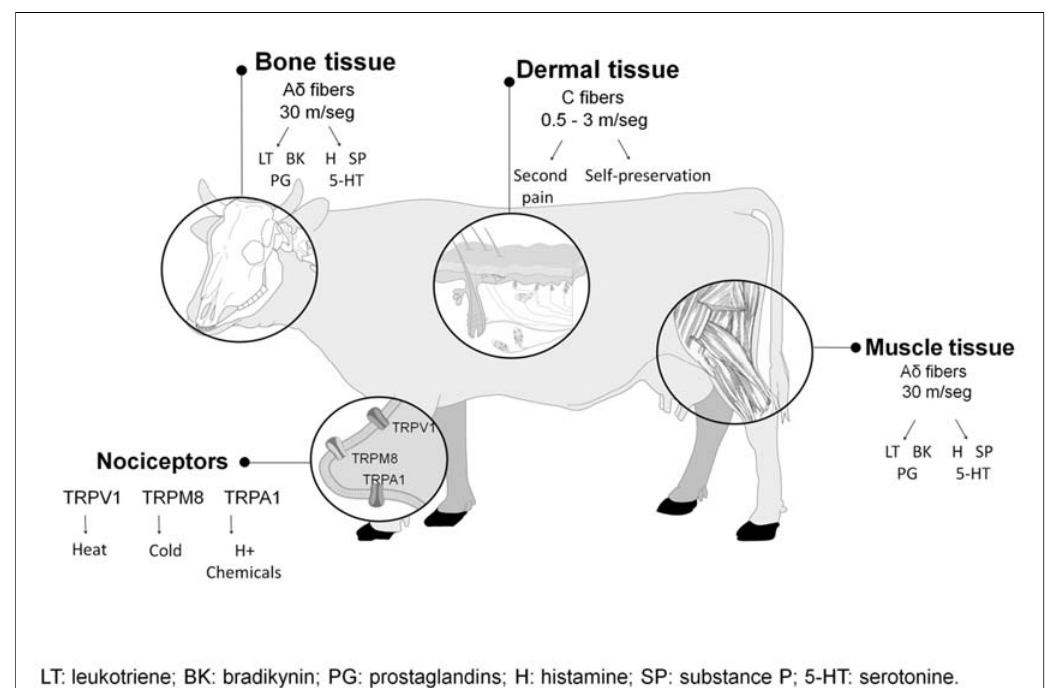
Figure 3. Schematic representation of the neurophysiological process of pain nociception in relation to the injured tissue and degree of trauma. Grade 1 trauma involves the skin, Grade 2 trauma has muscle involvement with the most severe (grade 3) trauma reflecting bone damage.